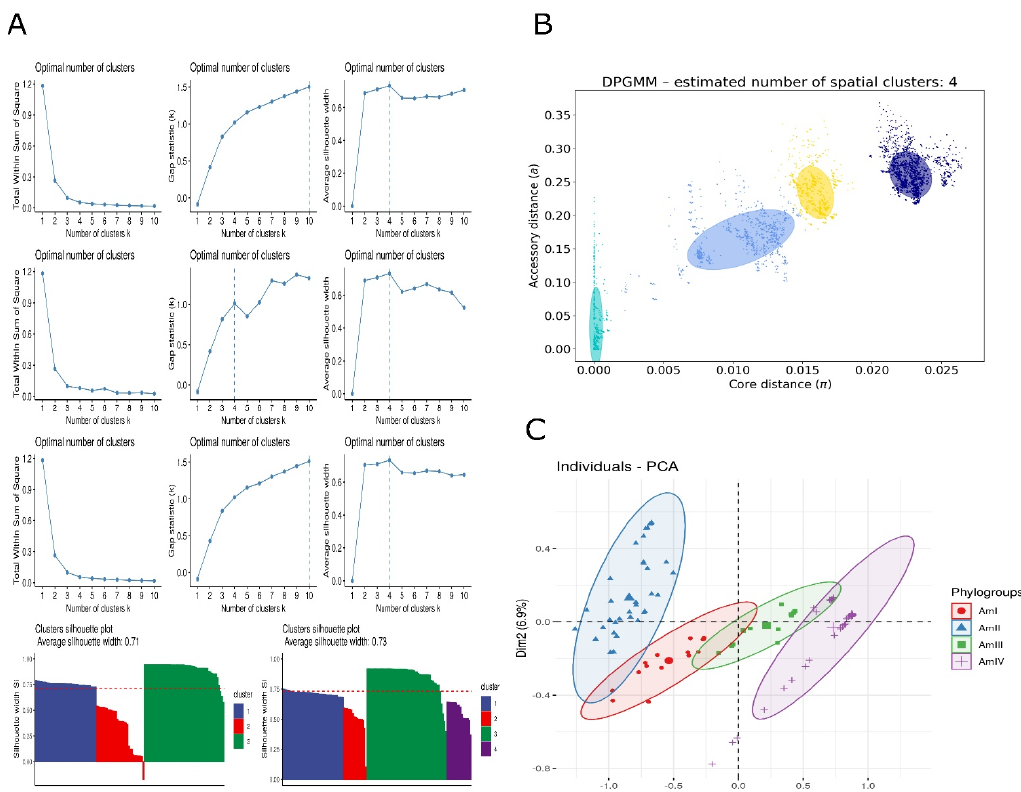
Figure 4. Clustering of strains into phylogroups. ( A ) (I–III) Partition around medoids clustering prediction using (I) within sum of square, (II) gap distances, and (III) silhouette distances. (IV–VI) Kmeans clustering prediction using (IV) within sum of square, (V) gap distances, and (VI) silhouette distances. (VII–IX) Hierarchical clustering prediction using (VII) within sum of square, (VIII) gap distances (IX), and silhouette distances. (X) Silhouette plot for three clusters. (XI) Silhouette plot for four clusters. ( B ) Dirichlet Process Gaussian Mixture Model-based clustering of strains into phylogroups using core distances and accessory distances. ( C ) Principal component analysis of gene presence-absence profile.